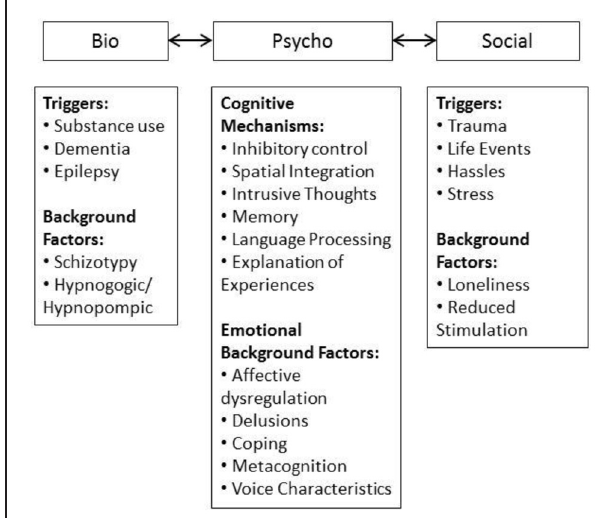
FIGURE 1 | Biopsychosocial framework used in the summary of the AVH